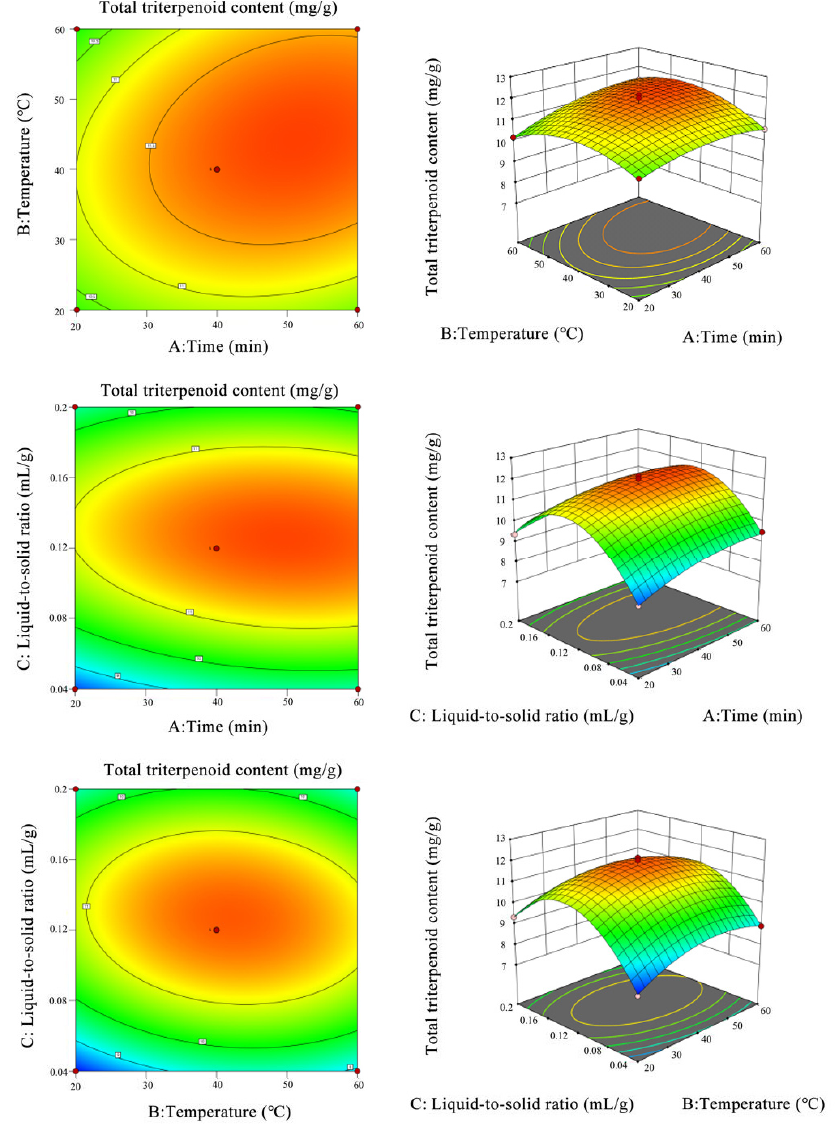
Figure 4. Response surface diagram and contour lines of different factors on total triterpenoid content in loquat pulp.